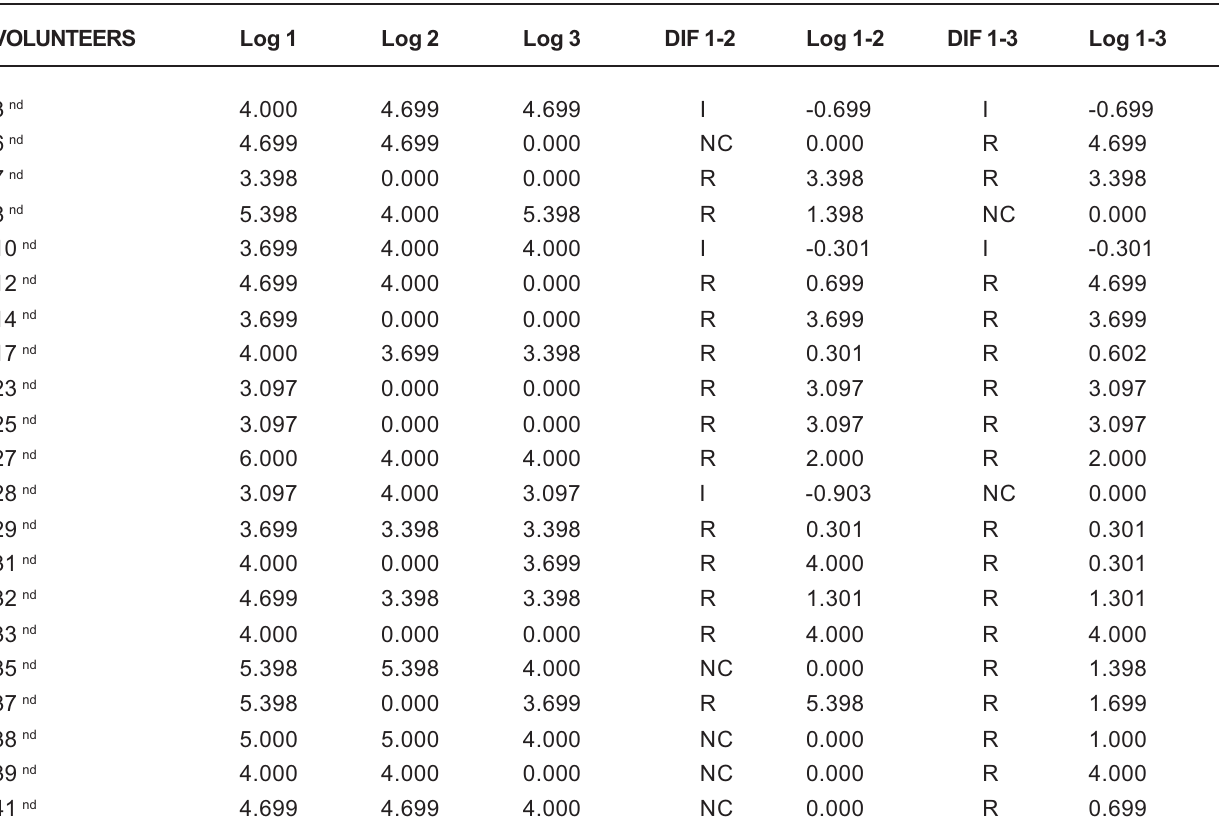
TABLE 2- Logarithmic difference in the number of Streptococcus mutans (CFU/ml + 1) between collections 1 and 2 and between collections 1 and